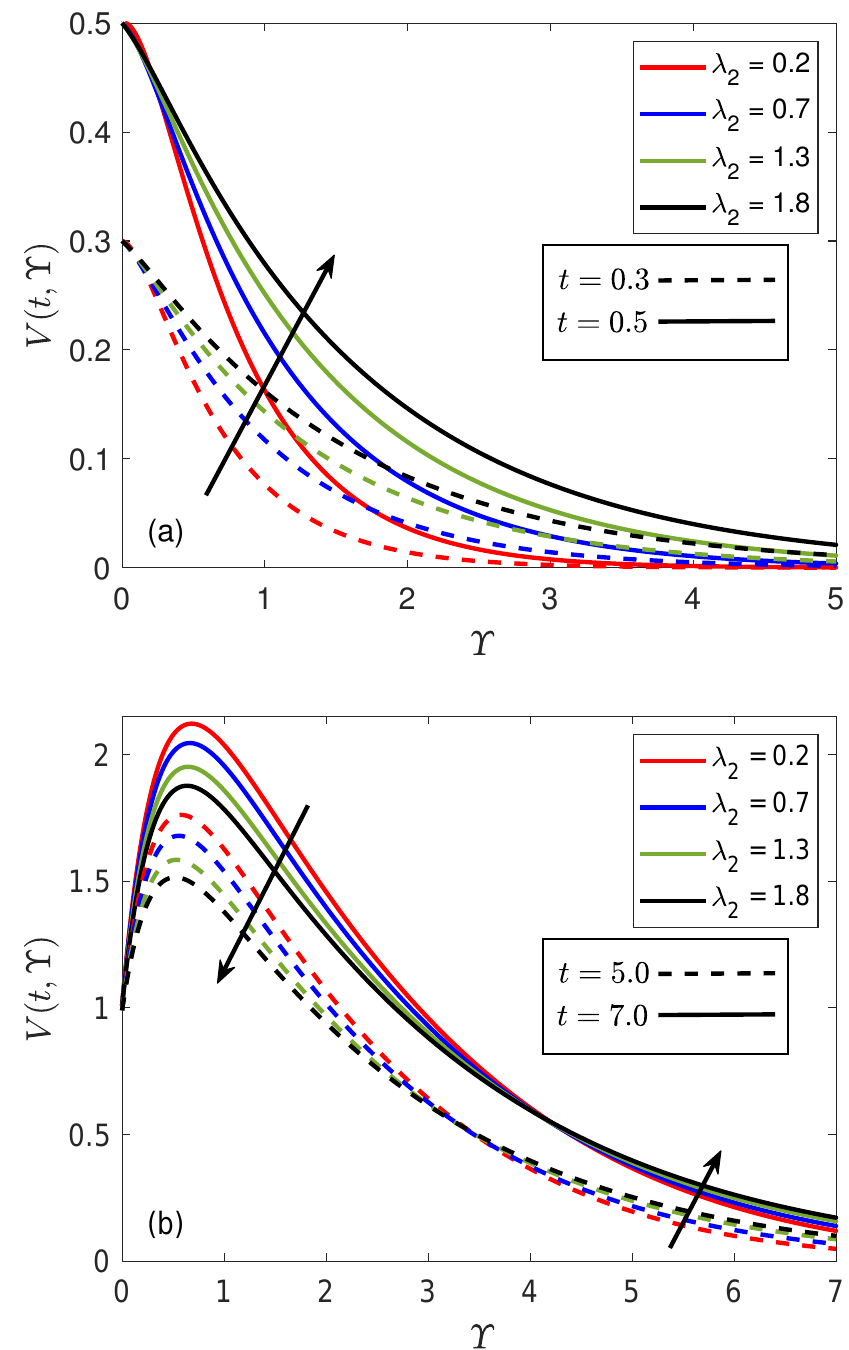
Figure 13. ( a ) Flow patterns corresponding to variations of λ 2 for smaller time inputs. ( b ) Flow patterns corresponding to variations of λ 2 for larger time